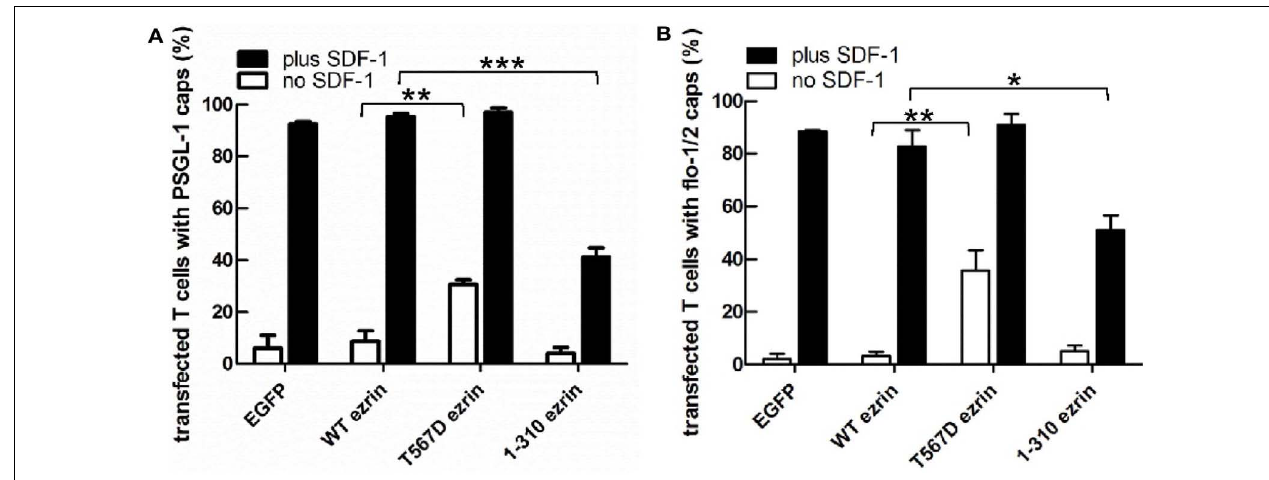
flotillin-mCherry caps was evaluated for the experiment shown in Figure 4B (mean ± SEM of four to five experiments¸ exception: EGFP: n = 2). Open bars: incubation for 30min without SDF-1; closed bars: stimulation with SDF-1 for 15min. * P < 0.05; ** P < 0.01; *** P < 0.001 for statistically significant differences between data as